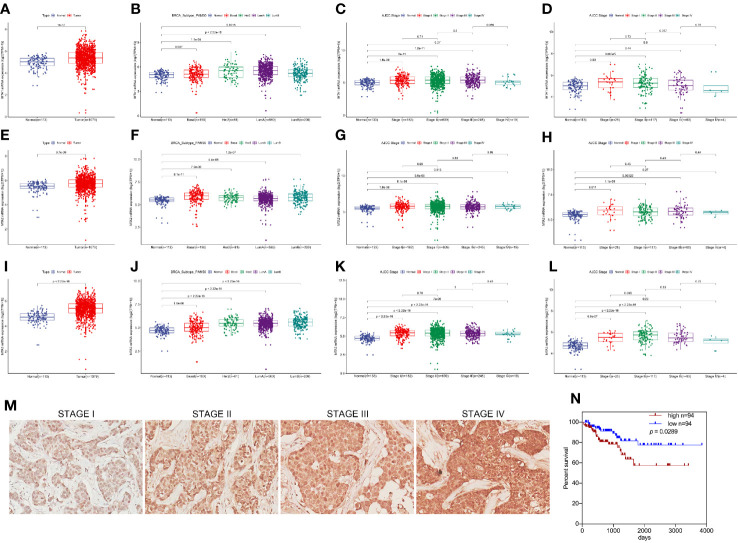
MTA1 is a prognosis factor of luminal-b breast cancer. (1) mRNA level of MTA1-3 in breast cancer tissues and adjacent normal tissues from TCGA data (A, E, I). (2) mRNA level of MTA1-3 in breast cancer tissues (TNBC, Her-2 type, Luminal_A and luminal-b) and adjacent normal tissues from TCGA data (B, F, J). (3) mRNA level of MTA1-3 in different clinical stages breast cancer tissues and adjacent normal tissues from TCGA data (C, G, K). (4) mRNA level of MTA1-3 in different clinical stages luminal-b breast cancer tissues and adjacent normal tissues from TCGA data (D, H, L). (5) IHC of MTA1 in luminal-b breast cancer tissue sections, which showed higher MTA1 expression with higher clinical stage (p<0.01) (M, N). (6) IHC showed the overall survival in high and low expression of MTA1 breast cancer groups, which revealed higher expression of MTA1 accompanied with worse prognosis (p=0.0289) (M, N).